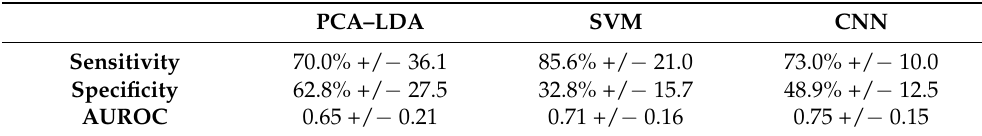
Table 1. Two-class models: mean sensitivity, specificity and AUROC across all folds +/ − 1 stan- dard deviation.